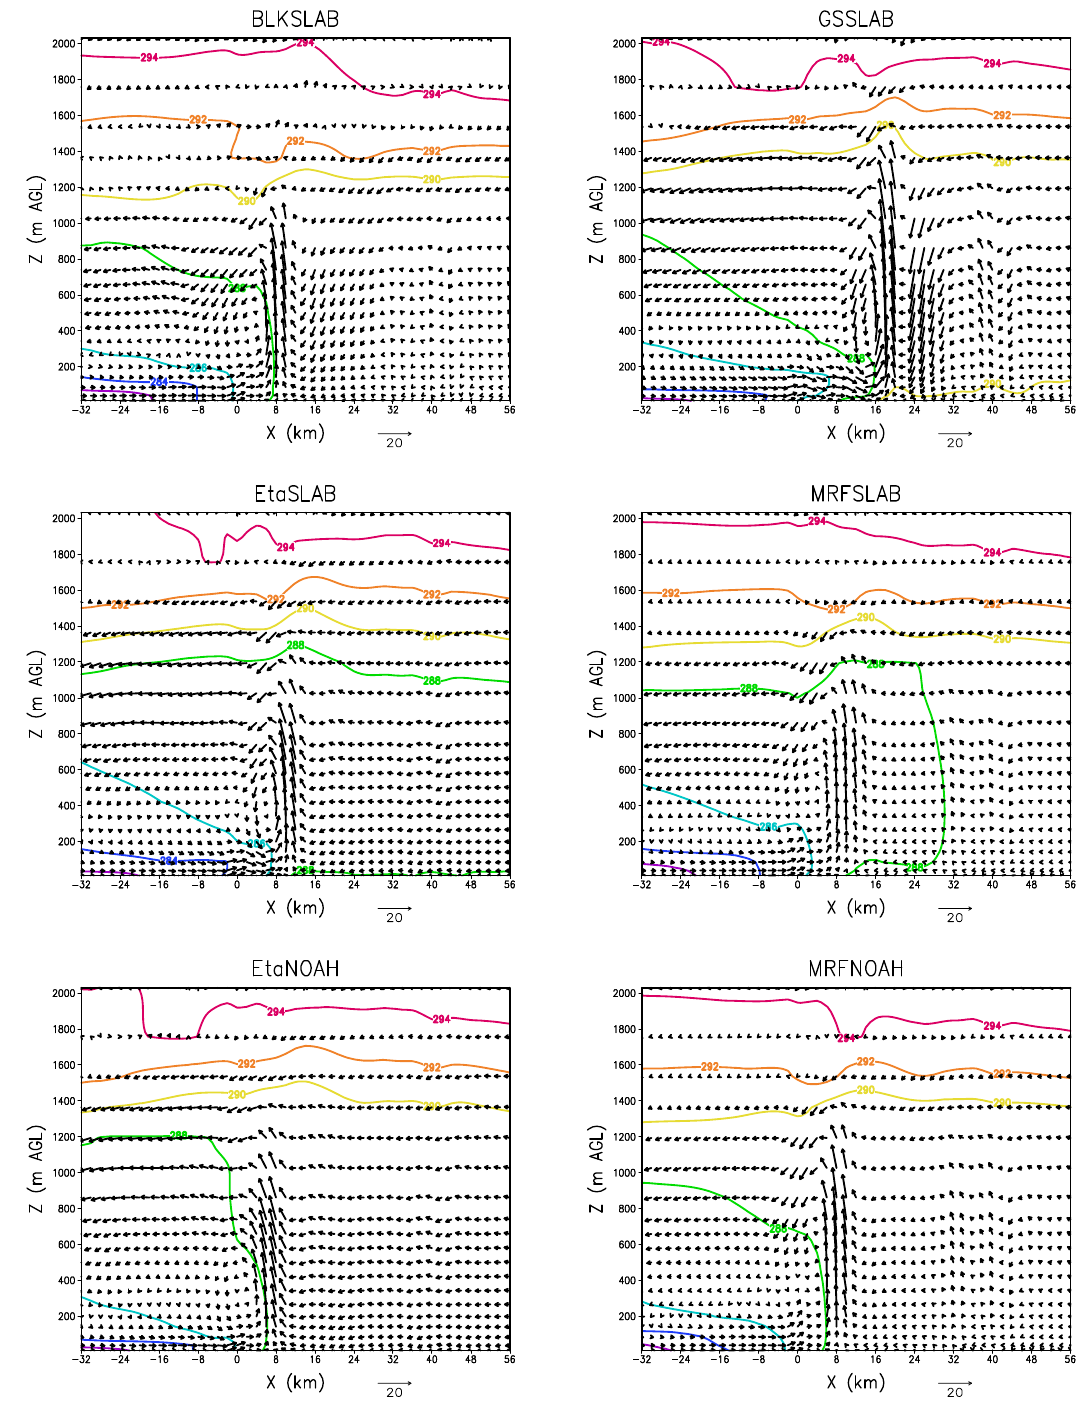
Fig. 9. Vertical cross section of simulated wind vector ( U - and W -component) and potential temperature along 57.72 ◦ N (cf. Fig. 1b) with different experiments at 15:00UTC 8 May 2001. The W -component has been multiplied by a factor of 50. Contour interval for potential temperature is 2K. Number 0 on abscissa (X-axis) indicates coastline. Positive number on X-axis is onshore (inland) distance from the coastline (in kilometers), while negative number is offshore distance from